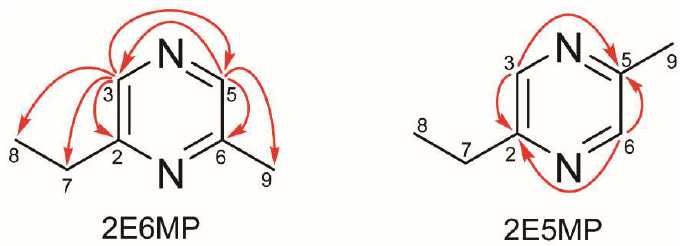
Figure 5. Selected HMBC correlations of EMPa and EMPb.